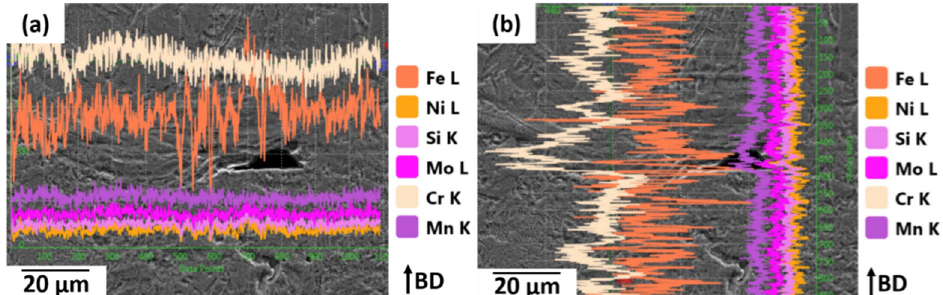
Figure 9. Microstructures showing the ( a ) horizontal and ( b ) vertical compositional line profile analysis superimposed on the SEM micrograph for the as-built sample. BD is the build